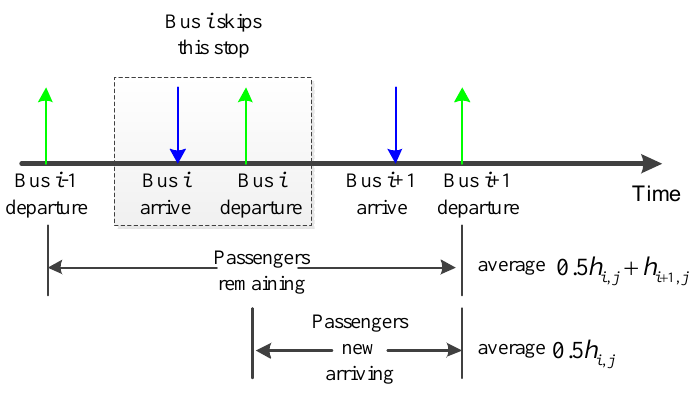
Figure 2. Passengers waiting time at a skipped stop.